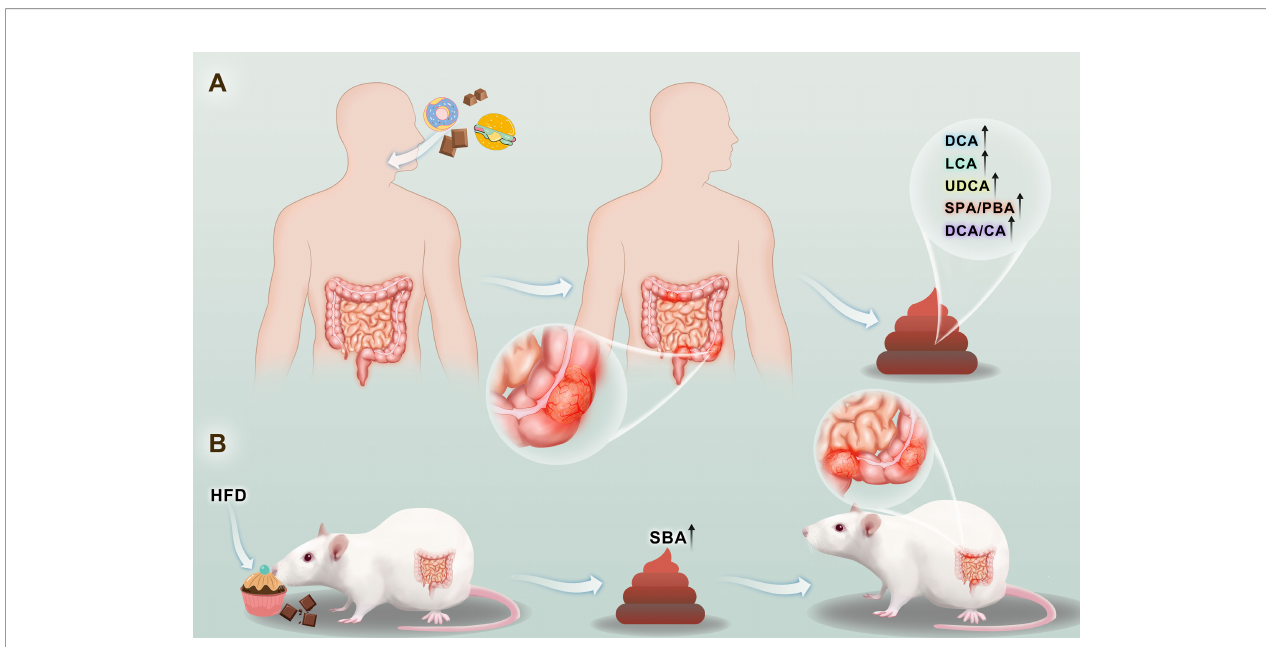
FIGURE 1 | The occurrence and development of colorectal cancer will be accompanied by the increase of secondary bile acid content in stool (A) . Consumption of a high-fat diet increases the levels of secondary bile acids in the stool, and increased levels of secondary bile acids have been contributed to the development of colorectal cancer (B)